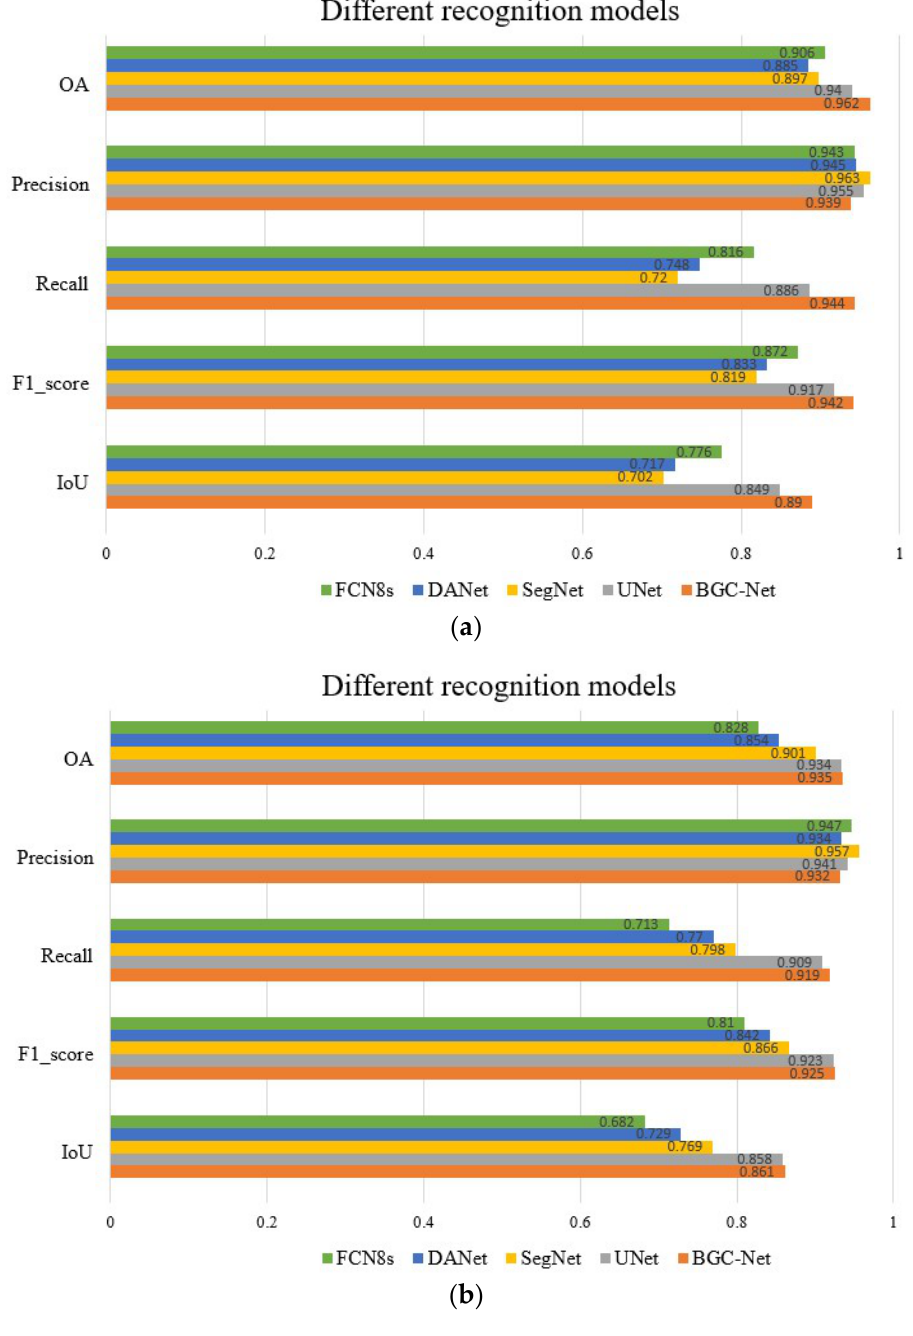
Figure 12. Quantitative results of different networks on the two datasets. ( a ) Quantitative results of different networks on the WHU dataset. ( b ) Quantitative results of different networks on the CHN dataset.